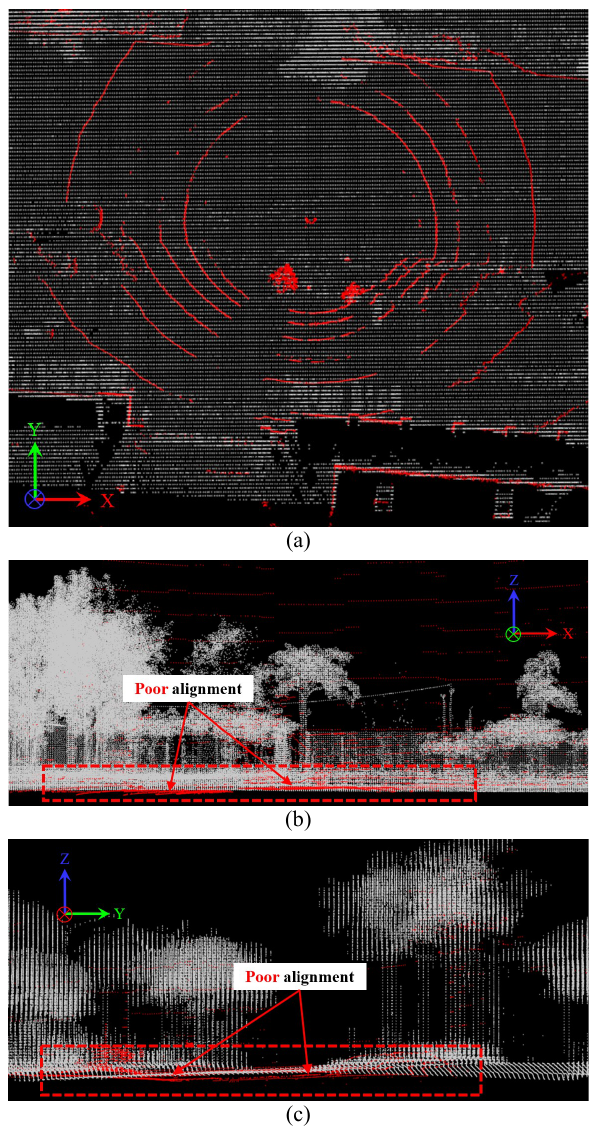
Figure 6 . Georeferenced points after calibration (green points): (a) xy-plane (top-view), (b) xz-plane (side-view), and (c) yz- plane